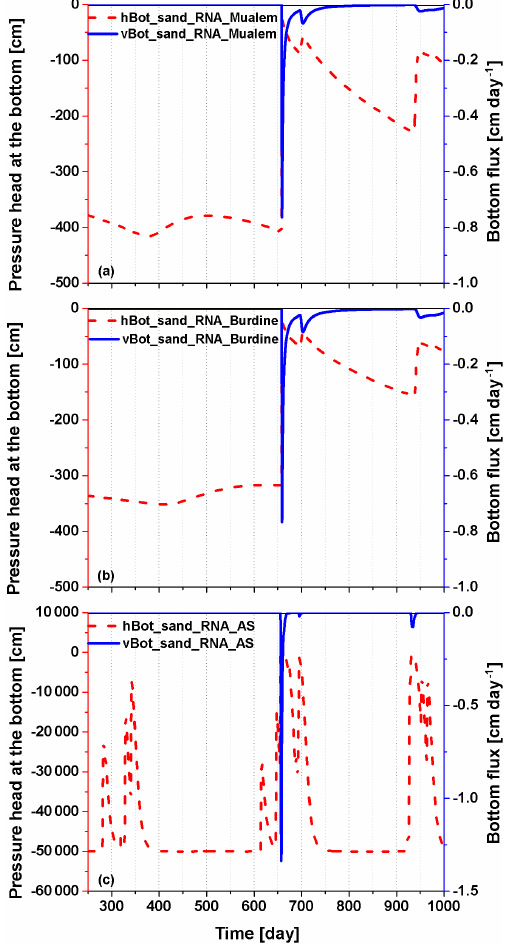
Figure 11. As in Fig. 10, but for the RNA parameterization (see Table